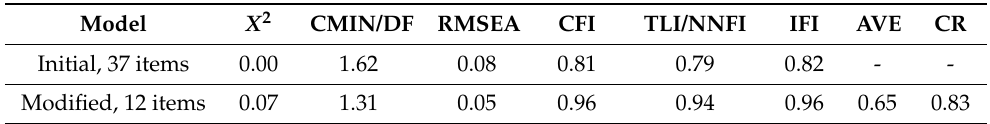
Table 2. CFA, AVE and CR of the AMPET-e instrument.